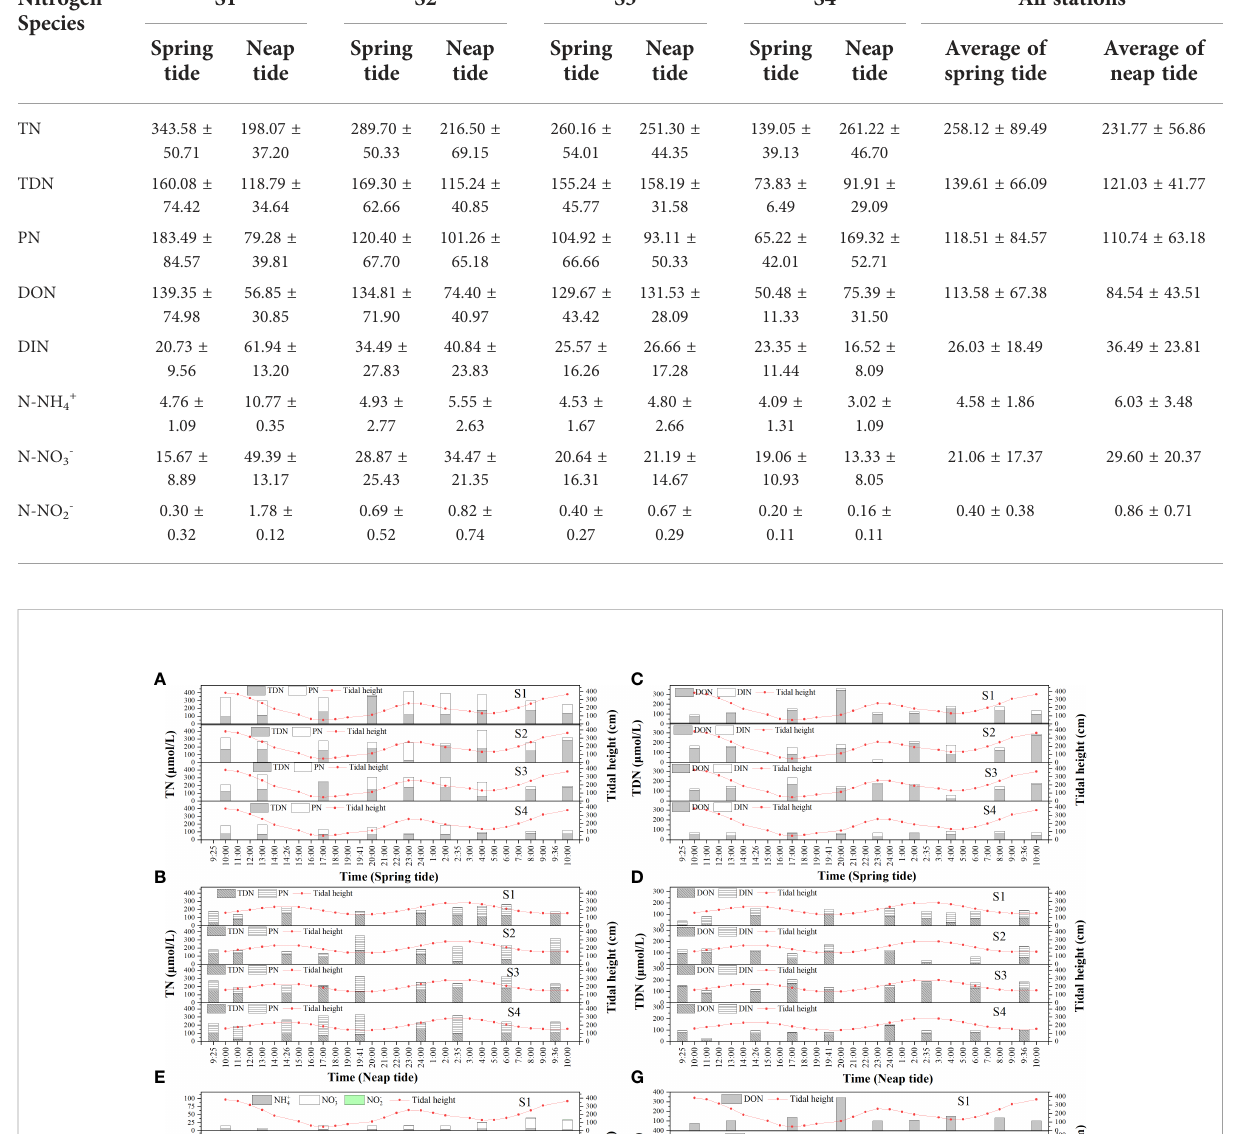
TABLE 2 Mean values of nitrogen species concentrations at each station in SDB ( m mol/L). Nitrogen